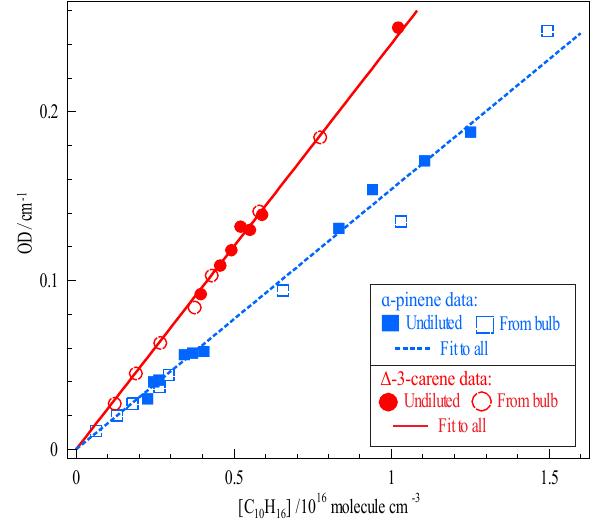
Figure 3. Beer–Lambert plots used to derive 184.95nm absorption cross sections: σ α -pinene (blue square data points) and σ (cid:49) -3-carene (red circles). Over a wide range of concentrations, good agree- ment was observed for data from both undiluted samples and from pre-prepared dilute bulbs (Sect. 2). Unweighted proportional fits with (Eq. 1) yield (in units of 10 − 17 cm 2 molecule − 1 )σ α -pinene = ( 1 . 54 ± 0 . 05 ) and σ (cid:49) -3-carene = ( 2 . 40 ± 0 . 03 ) .